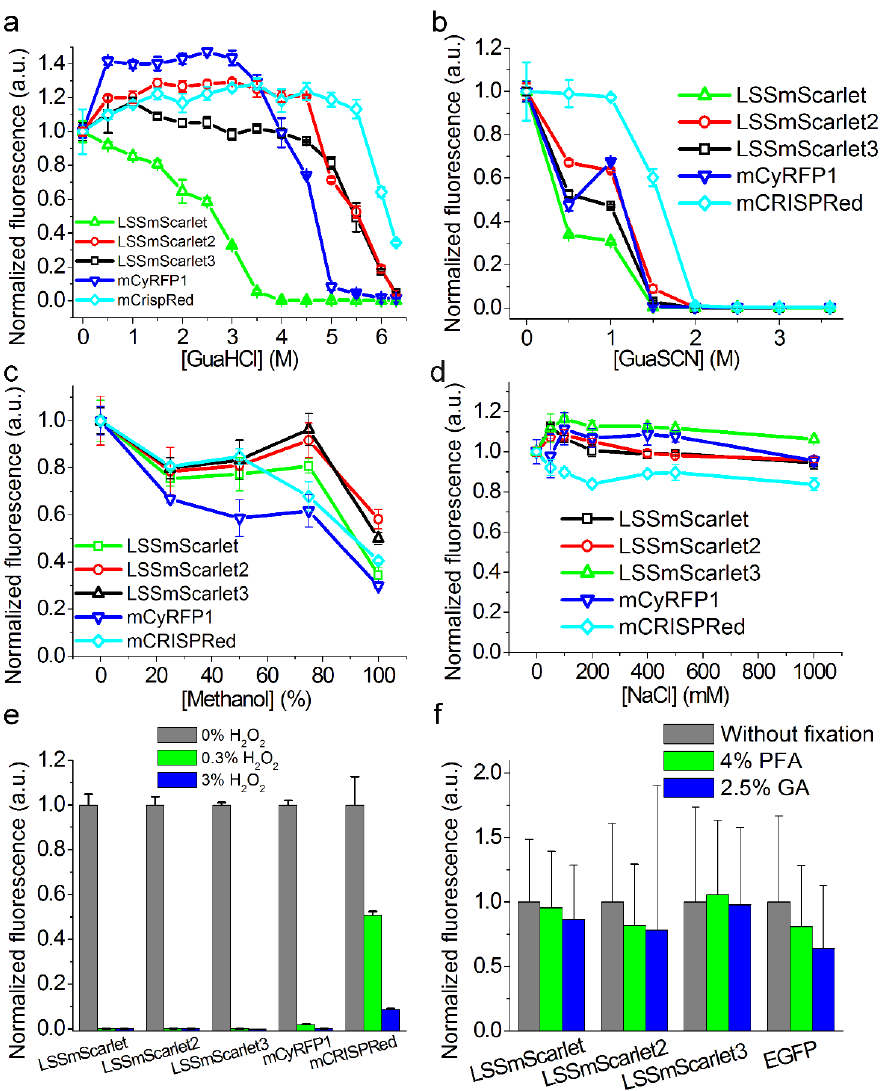
Figure 6. Chemical stability of LSSmScarlet, LSSmScarlet2, and LSSmScarlet3. Purified proteins (0.1 µM) were incubated ( a ) for 24 h at room temperature in 0, 0.5, 1, 1.5, 2, 2.5, 3, 3.5, 4, 4.5, 5, 5.5, 6, and 6.3 M GuaHCl; ( b ) for 24 h at room temperature in 0, 0.5, 1, 1.5, 2, 2.5, 3, and 3.6 M GuaSCN; ( c ) for 1 h at room temperature in 0, 25, 50, 75, and 100% methanol; ( d ) for 24 h at room temperature in 0, 50, 100, 200, 400, 500, and 1000 mM NaCl; or ( e ) for 15 min at room temperature in 0, 0.3, or 3% H 2 O 2 . ( f ) LSSmScarlet, LSSmScarlet2, or LSSmScarlet3 was coexpressed with EGFP in HeLa Kyoto mammalian cells, and then the cells were washed with DPBS and fixed with 4% PFA or 2.5% GA at room temperature for 15 min.